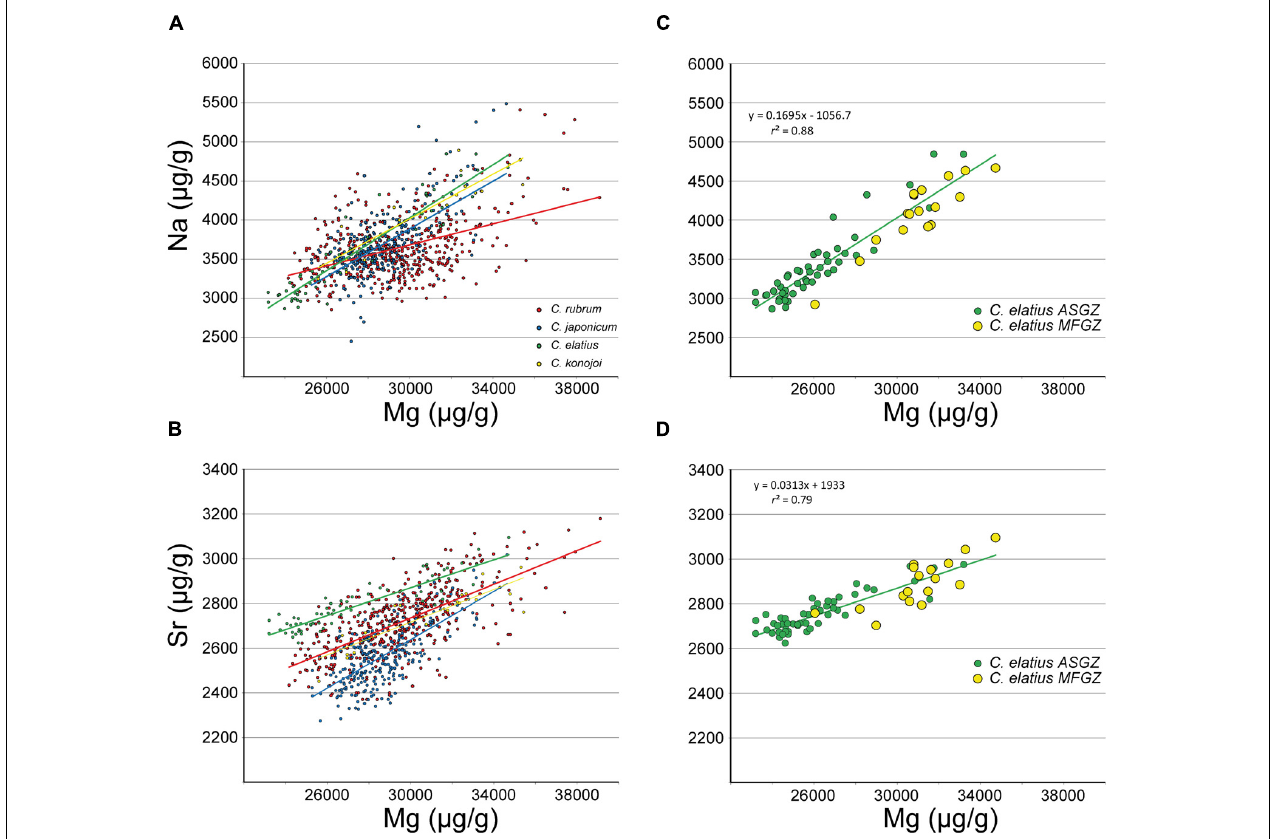
FIGURE 4 | LA-ICPMS data. (A,B) Na and Sr vs. Mg in C. rubrum, C. japonicum, C. elatius and C. konojoi and corresponding regression lines (equations and correlation coefficients are given as Supplementary Material SM1 Table 3 ). (C,D) C. elatius data extracted from (A,B) (equations and correlation coefficients from MFGZ and ASGZ combined data). ASGZ, annular slow growing zone; MFGZ, medullar fast growing